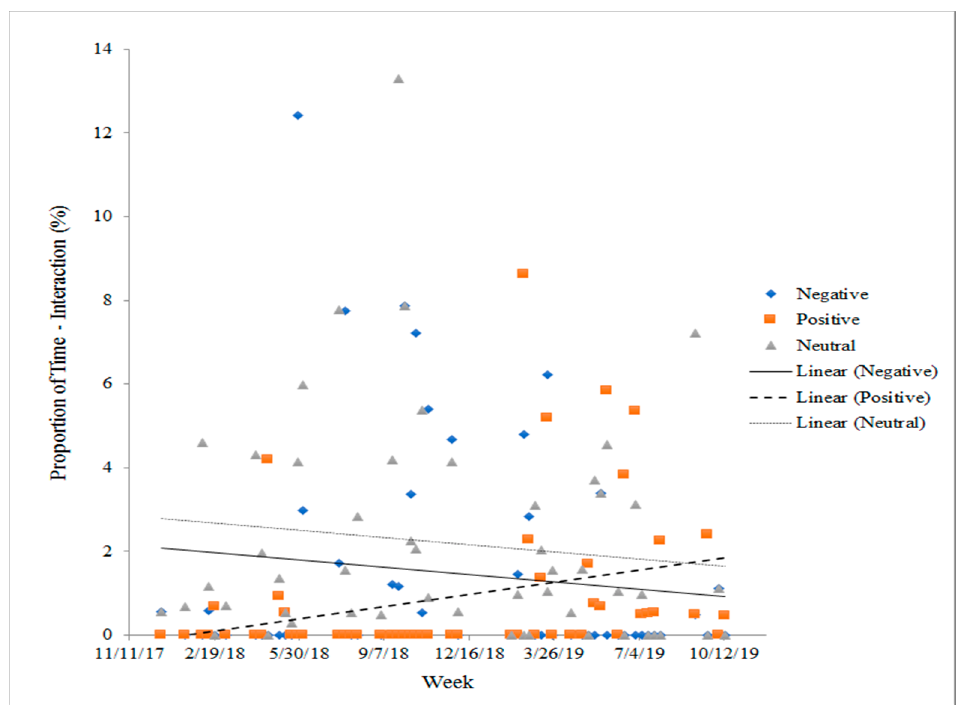
Figure 6. Each point represents the weekly combined proportion of total time that Bozie and Maharani interacted positively, negatively, or neutrally with each other, documented using 30 min focal observations. A significant increase in positive social interactions is noted over time as introductions continue between these two females.